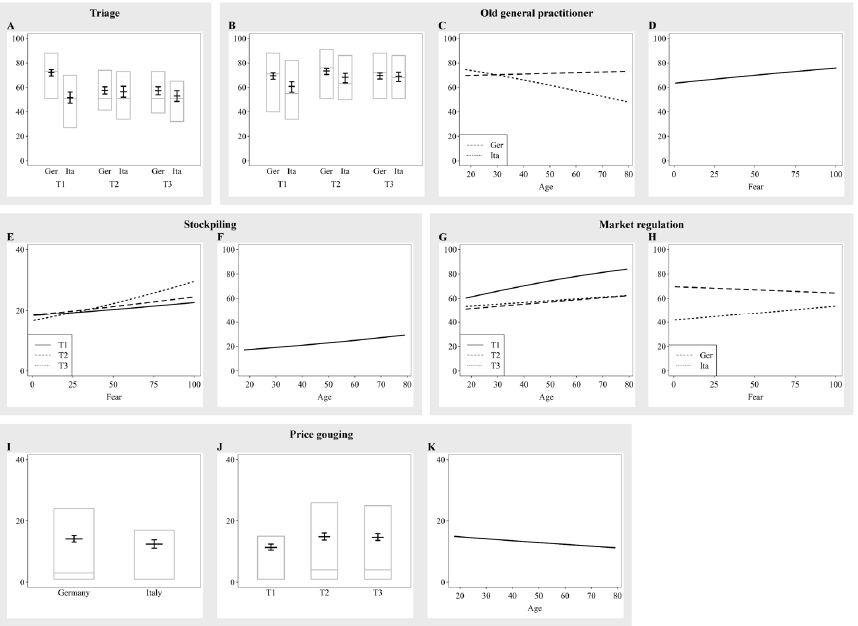
Figure 2. Estimates of the significant main effects and interactions for the ratings of the moral sce- narios that were presented in all assessment periods. ( A ) Triage; ( B – D ) Old General Practitioner Dilemma; ( E , F ) Stockpiling; ( G , H ) Market regulation; ( I – K ) Price